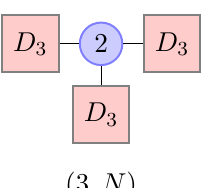
Figure 1 . Our AD theory of interest, (3 , 2) , consists of an exactly marginal diagonal SU(2) gauging of three D 3 (SU(2))